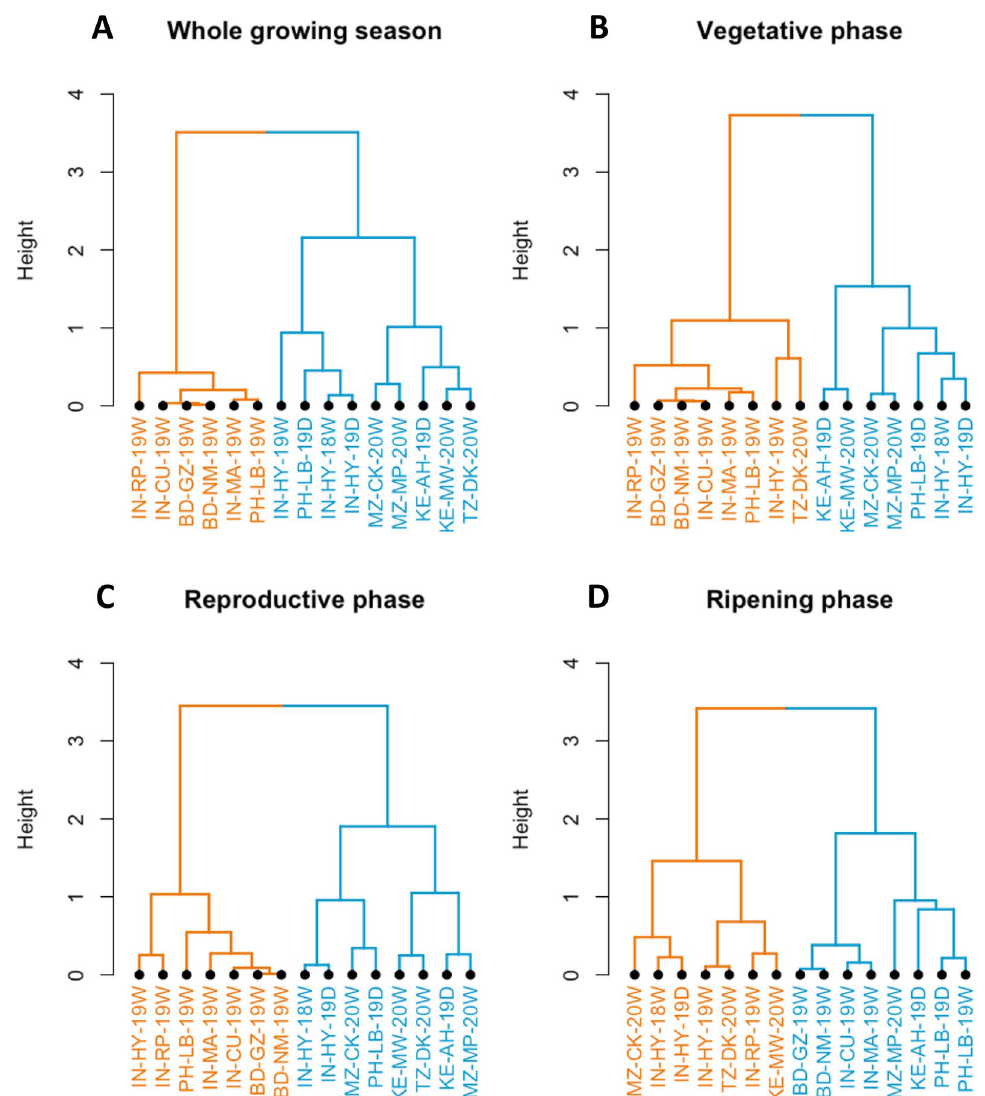
Fig. 4 Hierarchical clustering of environments upon ECs throughout ( A ) the whole growing season, each developmental phase ( B – D ). Different colors show the different clustering between environments. The names of environments in the clusters are formatted by ordering country name, location, year, and season (see Table